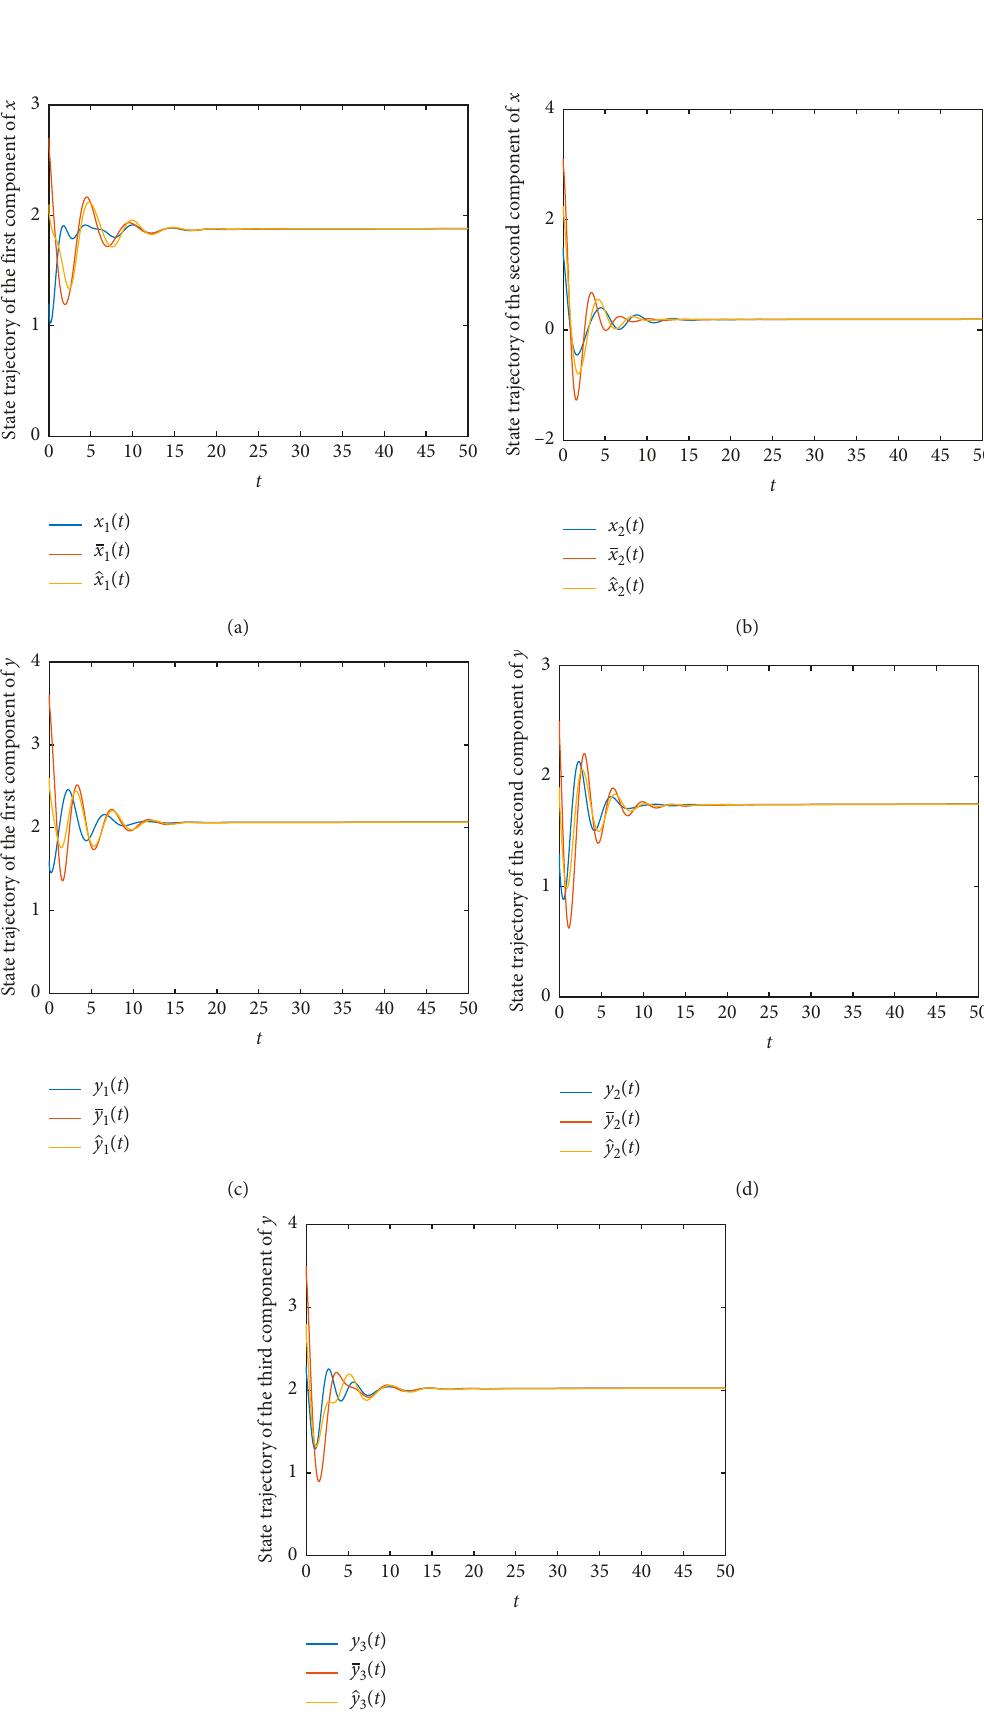
Figure 8: State trajectories of the system for three initial conditions in Example